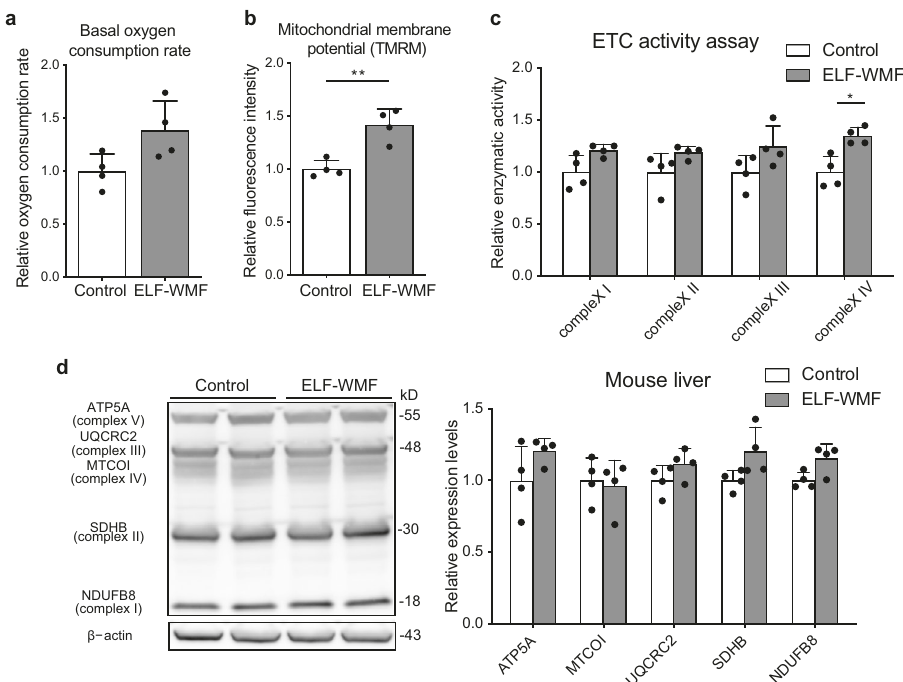
Fig. 1 Exposure to Opti-ELF-WMF for 4 weeks increased mitochondrial electron transport chain (ETC) activities in the mouse liver. a Basal oxygen consumption rate was measured by a fl ux analyzer using mitochondria isolated from the mouse liver. No statistically signi fi cant difference was observed by Student ’ s t -test (mean ± SD, n = 4 mice each). b Membrane potential of mitochondria isolated from the mouse liver was measured by fl ow cytometry with tetramethylrhodamine (TMRM; mean ± SD, n = 4 mice each; ** p < 0.01 by Student ’ s t -test). c Relative enzymatic activities of mitochondrial electron transport chain (ETC) complexes I, II, III, and IV of the mouse liver (mean ± SD, n = 4 mice each; * q [false discovery rate] < 0.05 by multiple Student ’ s t -tests). d Western blo t ting of the mitochondrial oxidative phosphorylation proteins in the mouse liver (mean ± SD n = 4 mice each; no statistical difference was observed by false discovery rate with multiple Student ’ s t -tests). Representative duplicates of Western blot analysis are shown. See also Fig. S1.